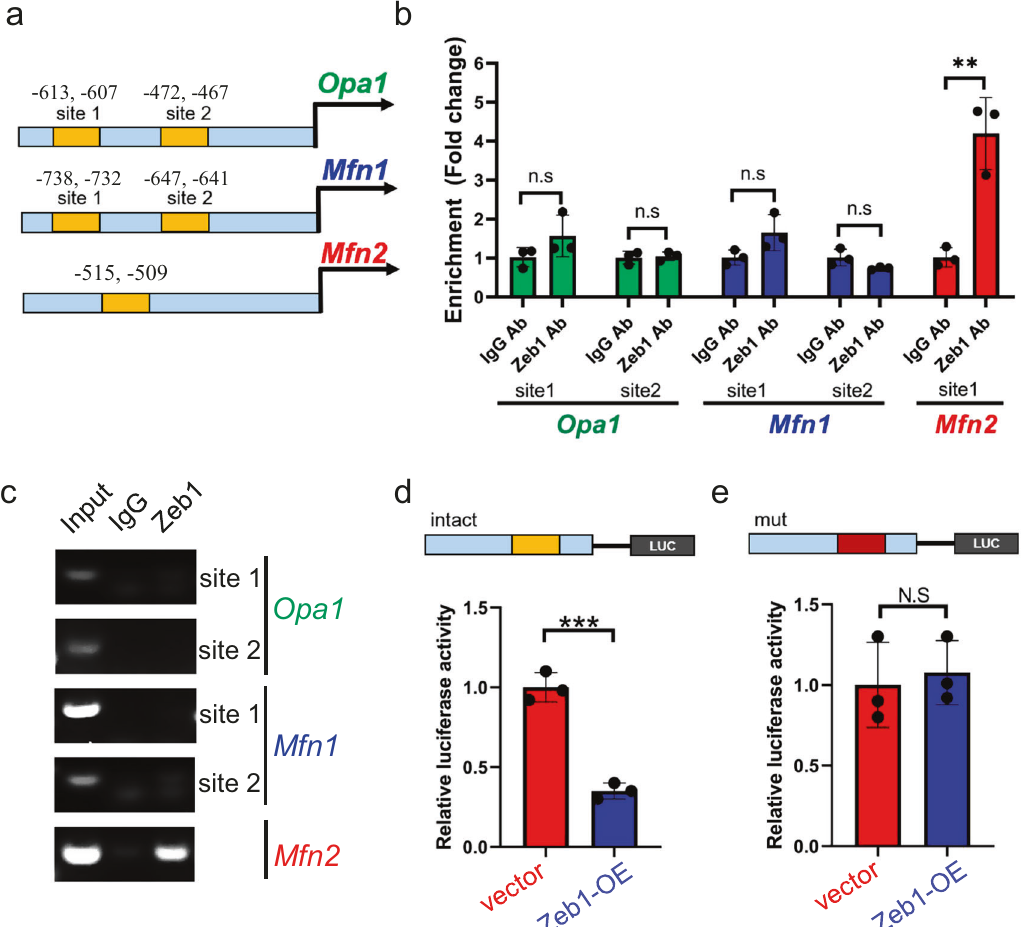
Fig. 7 Zeb1 suppresses mitochondrial fusion by targeting Mfn2 . a Identi fi cation of the putative bind sites of Zeb1 from start transcription site (STS) in the promoter regions of Opa1 and Mfn1 and Mfn2 . b ChIP-qPCR reveals the binding of Zeb1 to the putative binding sites located at the Opa1 , Mfn1 , and Mfn2 promote regions. ** p < 0.001, N.S no signi fi cance. c Semi-quantitative ChIP showing the association of Zeb1 with the putative binding motifs at the Opa1 , Mfn1 , and Mfn2 promote regions. d The intact Mfn2 promoter region was cloned into a luciferase